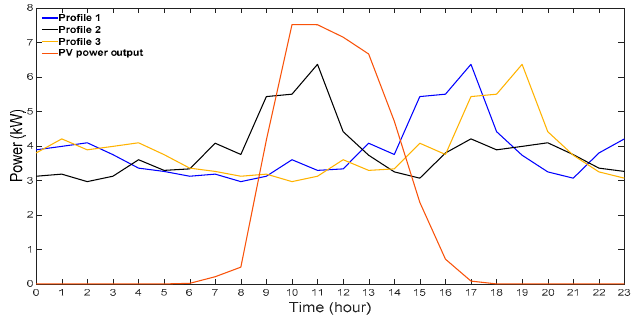
Figure 4. Daily load and PV power output profiles (31 January